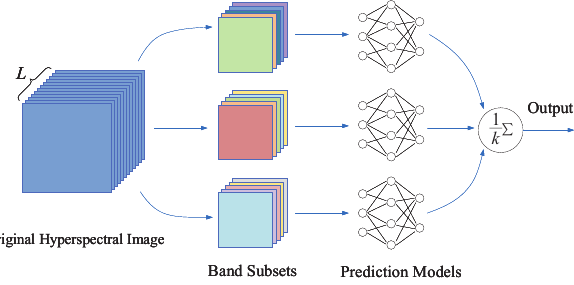
Figure 3. Integration operation using multiple band